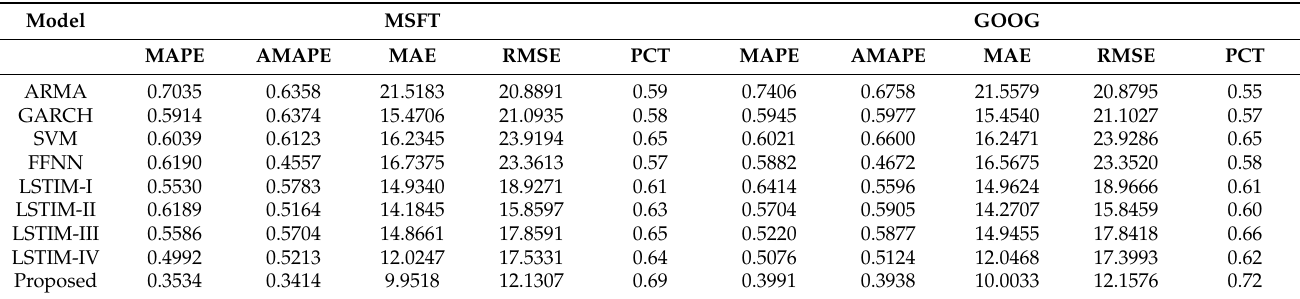
Table 16. Prediction performance for 300 days: MSFT and GOOG.